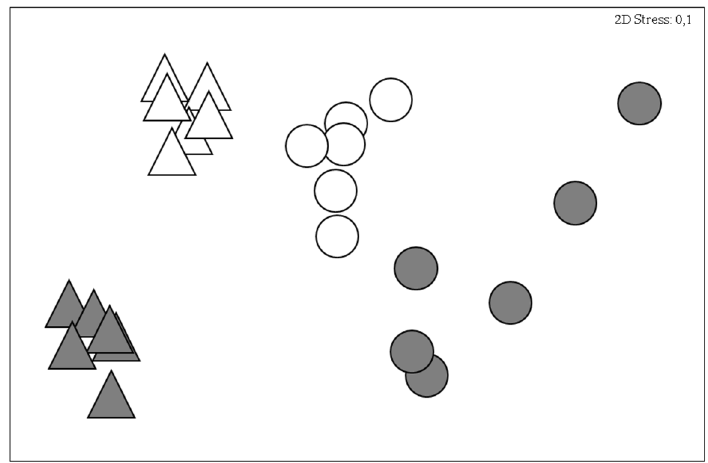
Figure 4. Two-dimensional n-MDS plot showing similarities of fouling communities between artificial environments and regions ( n = 6). Triangles, sea-cages; circles, marinas. Filled symbols, SW; open symbols, SE.